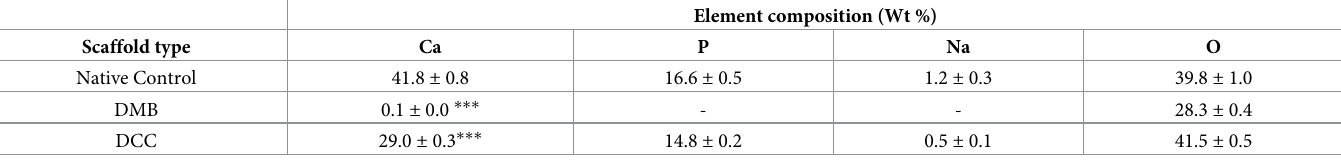
Table 1. Percentage of surface chemical elements detected in DMB and DCC scaffolds compared to native control.